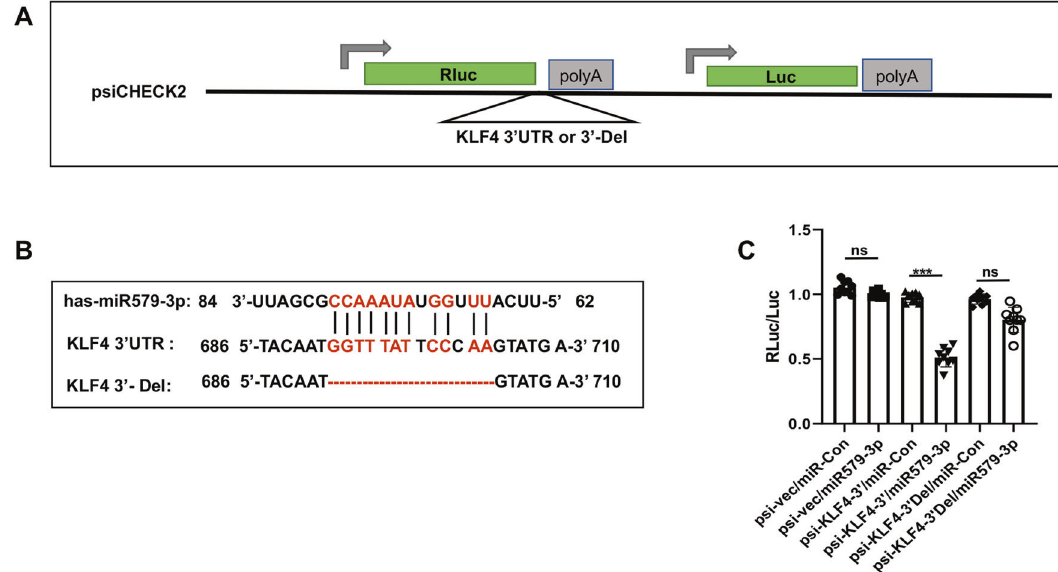
Fig. 5 miR579-3p targets the KLF4 mRNA 3 ′ UTR. Wild-type and 13 bp deletion of 3 ′ -UTR of KLF4, was ampli fi ed from the human genome and subcloned into the XhoI and NotI sites between Renilla gene and polyA of the psiCheck2 vector. Each constructed luciferase reporter plasmid or empty vector was transfected into AoSMCs at 5000 cells per well in 96-well plates. Luciferase was assayed at post 48 h transfection using the Dual-Luciferase Reporter Assay System. Luminescence was quantitated and renilla luciferase readings were normalized against the fi re fl y luciferase activity to determine the relative luciferase activity. Data are presented as mean ± SD ( n = 8 replicates). Pairwise comparison was made through Student ’ s t-test: *** P < 0.001; n.s. not signi fi cant. A Schematic of the luciferase reporter vector and constructs. B The miR579-3p sequence complementary to that of the KLF4 3 ′ UTR. C Relative luciferase activity compared between miR579-3p and